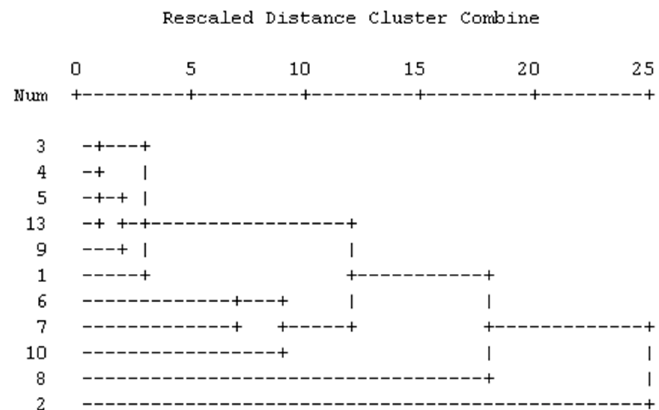
Figure 2. Analysis by hierarchical clusters showing the degree of similarity of the ecological profile of the sampled areas. There are two main clusters: One grouping with areas 3, 4, 5, 13, 9, and 1 and another with areas 6, 7, and 10.